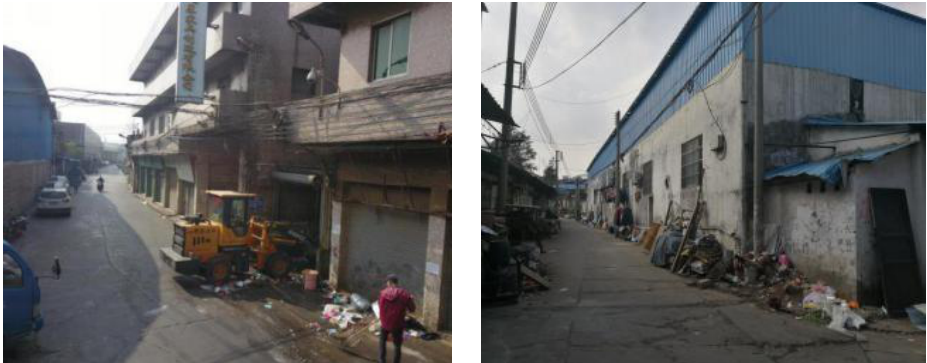
Figure 2. Rural industrial land landscape in Shunde District (Source: Urban Renewal Bureau of Shunde District).